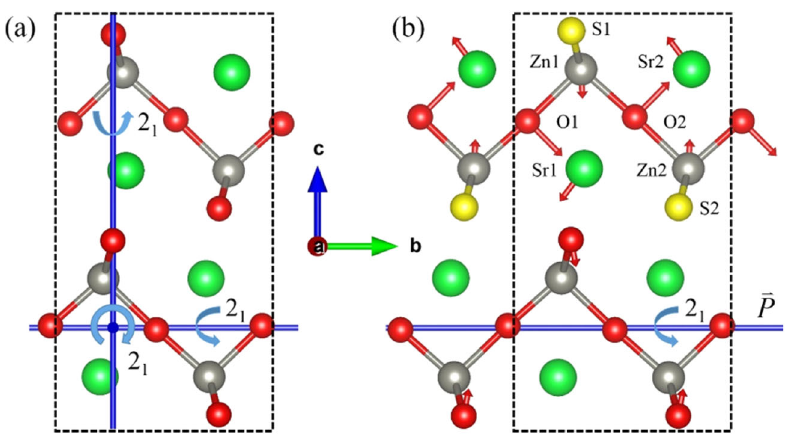
Fig. 3 Anion substitution induced ferroelectricity in ZnSrO 2 with a non-perovskite structure. a The original structure of ZnSrO 2 . The three screw axes are shown. b The FE structure of Zn 4 Sr 4 O 6 S 2 obtained by replacing one fourth of the oxygen atoms with sulfur